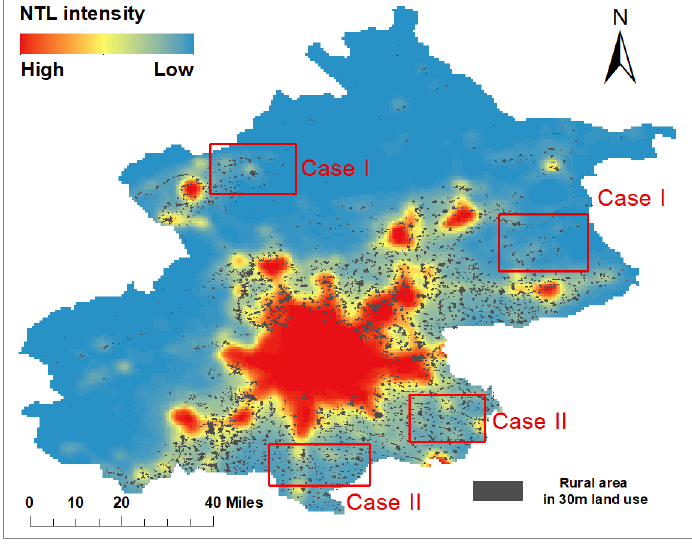
Figure 7. Distribution of rural settlements and night lights.